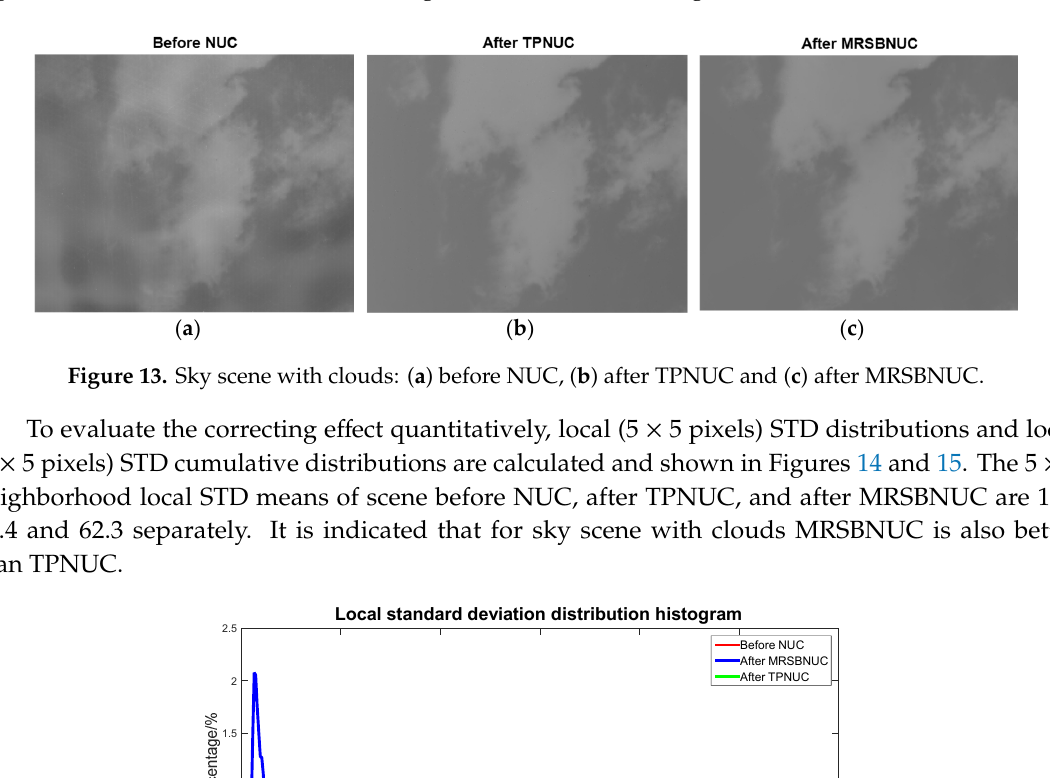
Figure 15. Local standard deviation cumulative distribution of sky scene with clouds: before NUC, after TPNUC, and after MRSBNUC. 3.3. Target Detection Figure 16 is the screenshot of ADSB Scope Software. Targets could be found manually based on the ADSB data. The distance between one target and the IR system can also be calculated employing the geodetic coordinate system. The experiment was done repeatedly on different dates, and some targets were captured. In order to show the effectiveness of the algorithm, among those targets two representative targets in the cloudy scene were selected to introduce the experimental results. In Figure 16a, Target 1 Airline 0 from Korea was detected. It is 48.36 km away from the IR system. In Figure 16b, Target 2 Airline 4 from China was detected. It is 50.53 km away from the IR system. ( a ) ( b ) Figure 16. ADSB receiver data shown on ADSB Scope Software: ( a ) Target 1 Airline 0 from Korea was detected; ( b ) Target 2 Airline 4 from China was detected.